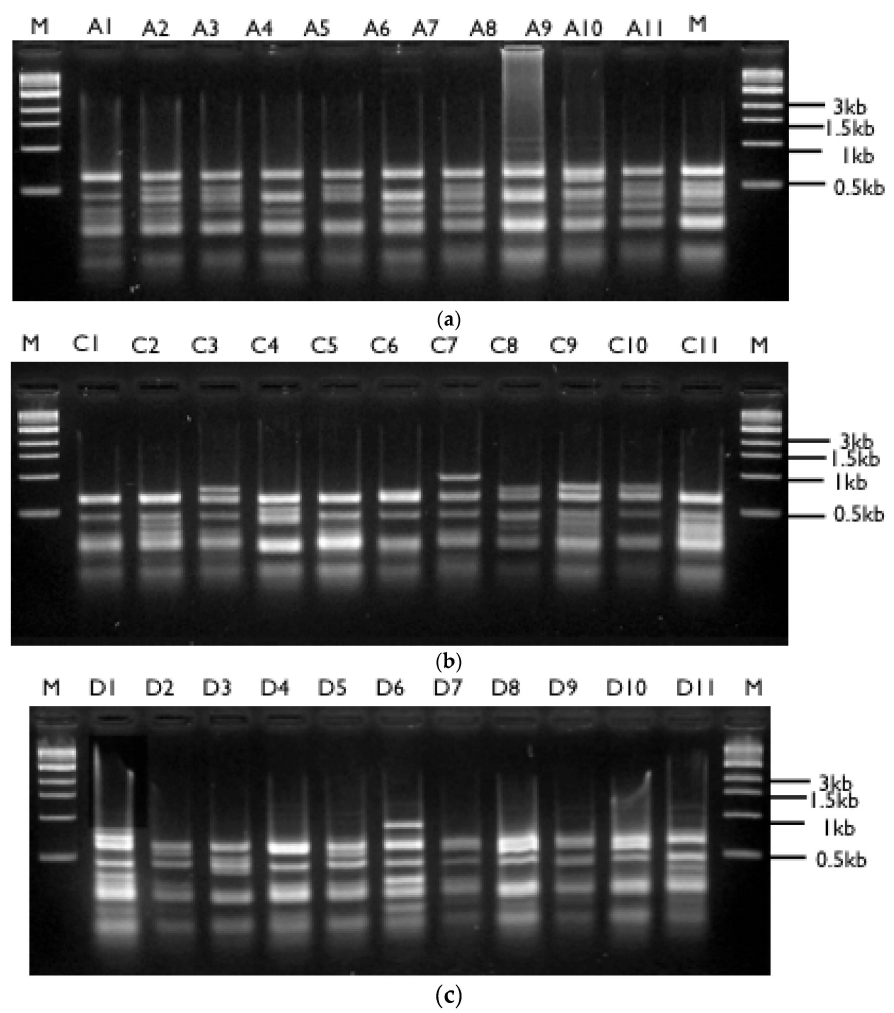
Figure 2. RFLP profiles of 18S rDNA obtained from unique clones using Alu I restriction digest. ( a ) Savannah River mudflat sample; ( b ) Agar medium grown cultured material from Savannah River mudflat; ( c ) Cultured material in liquid media from Savannah River